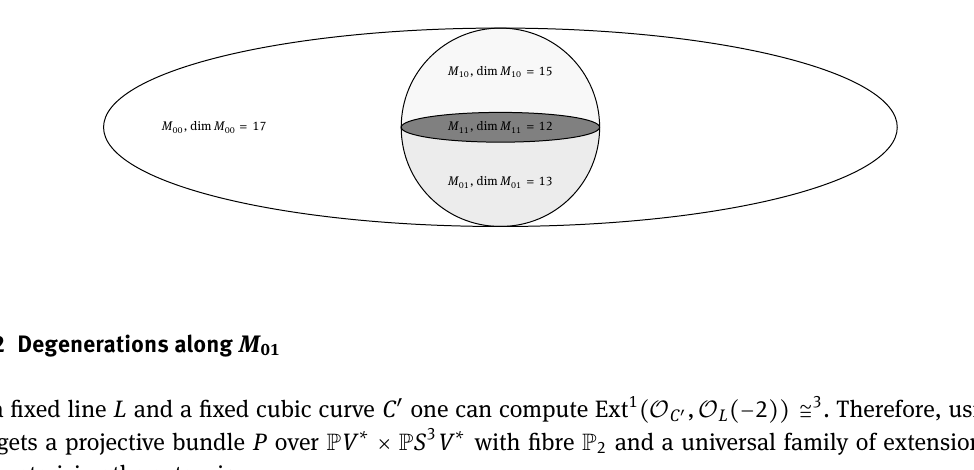
Fig. 1. Moduli space M = M 4 m − 1 ( P 2 )